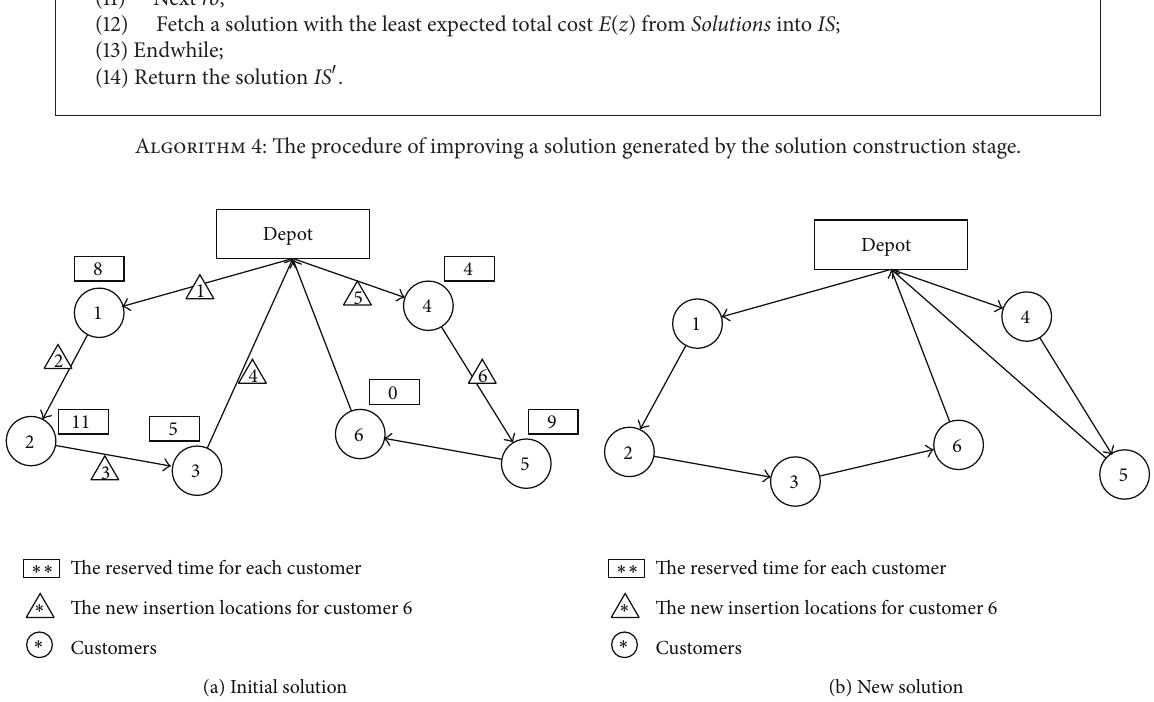
Figure 3: An example of deleting a customer from a route and inserting them to another